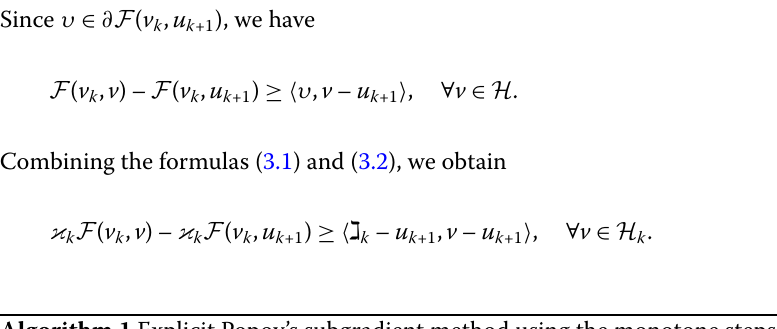
Algorithm 1 Explicit Popov’s subgradient method using the monotone stepsize